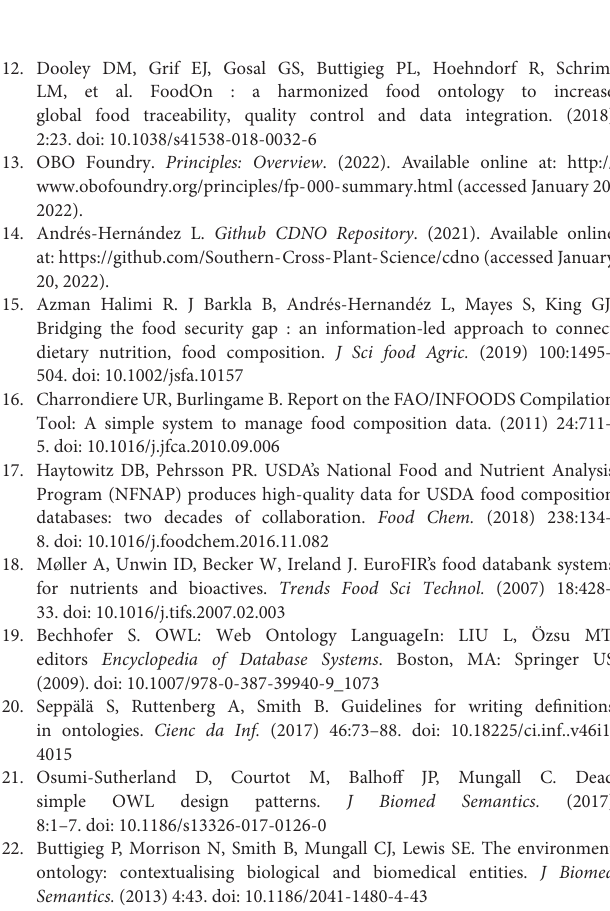
outcomes. The symbols under each domain correspond to each of the major CDNO and FoodOn classes represented in Figure 1 . Supplementary Figure 2 | Use-case of CDNO terms used to mine and compare data from diverse sources. Online graphical interface developed to demonstrate how the ‘ concentration of dietary nutritional component in material entity ’ [CDNO:0200001] classes are associated with quantitative data derived from (i) genetic resources, (ii) food composition tables and (iii) a geo-spatial study. Data associated with distinct data sources (see below) have been curated within a relational schema to enable semantic search and filtering based on annotation of key records, where ontology terms are managed within an ‘ontology register’ table. The user may navigate the hierarchical class tree (here, CDNO v3.0) and select (green solid circle) a nutritional component (e.g. CDNO:0200138 - ‘calcium concentration’). Food or crop groups may be selected (olive solid circle) and then refined to e.g. specific crops or organismal parts used for food. Data from the filtered datasets may be represented by a combination of box-whisker plots, frequency distributions, or single values. Calcium concentration data were sourced to represent variation within (i) a crop biodiversity collection representing the vegetable Brassica oleracea genepool (52), the Brassica Information Portal (45) (ii) vegetables and vegetable products from a food composition database - the Canadian Nutrient File (53) - cited in (46) and (iii) a geo-spatial study where crop-based edible food items were sampled from multiple locations in Malawi, with data presented for variation in the underutilized crop Moringa oleifera (47). Recorded values have been adjusted to enable direct comparison on a consistent y-axis, as the original units varied according to each study (i) %, (ii) mg/100g, (iii) mg per kg. For (ii), as for many food composition databases, only single values per nutrient component per food are available (15), although the number of original samples from which the mean value is derived is